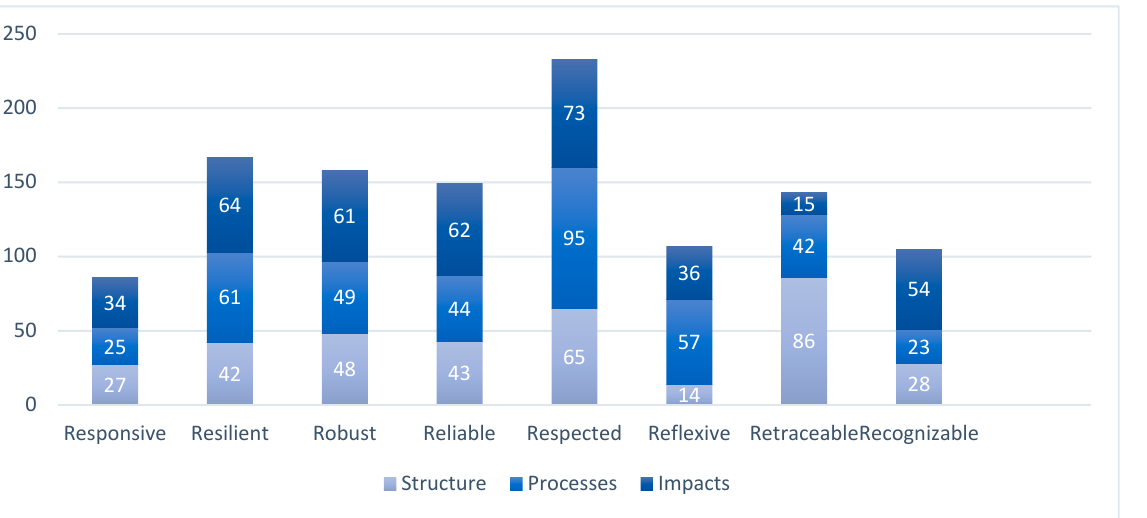
Figure 3. Number of Rs found during data collection.